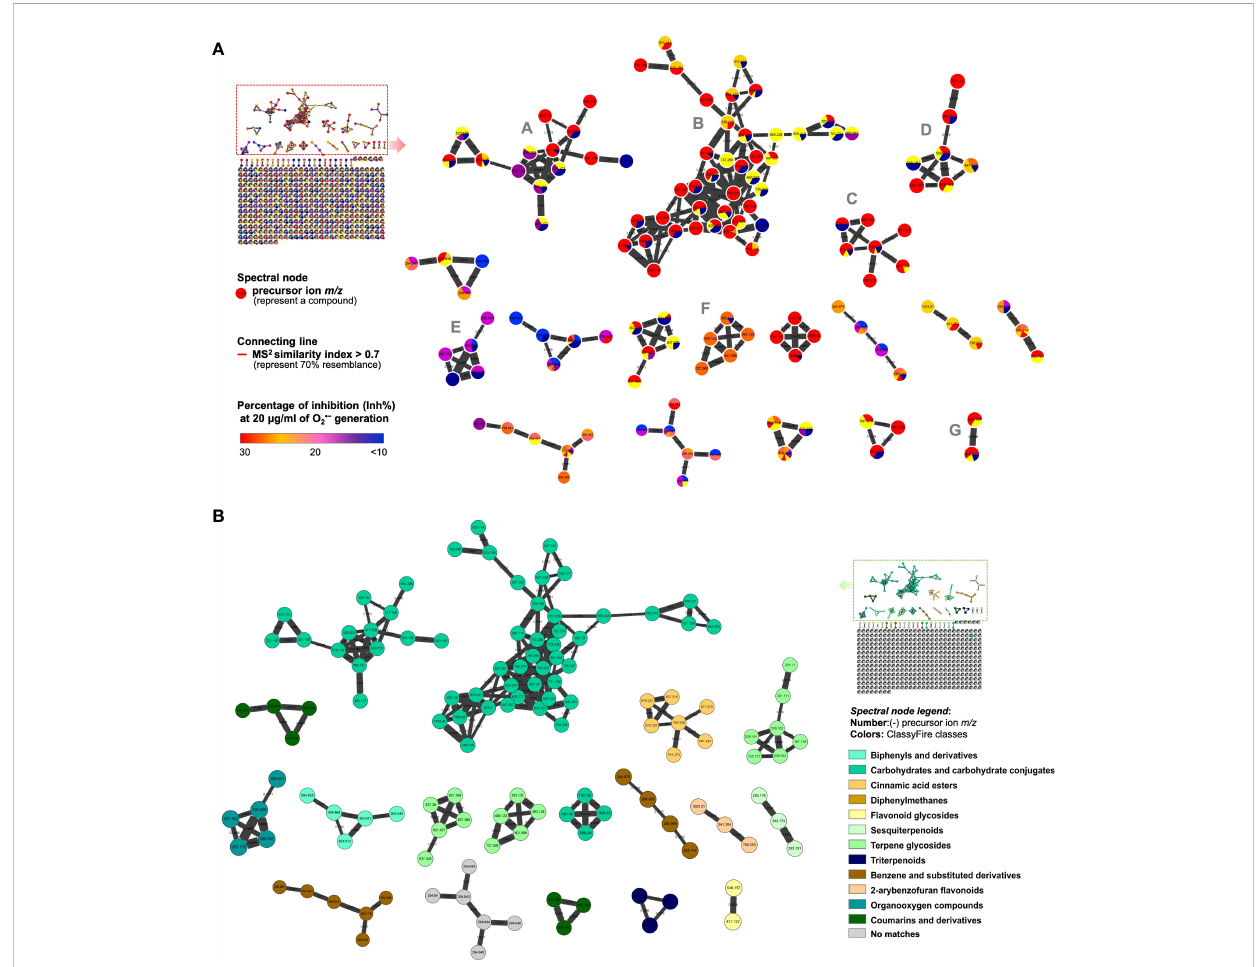
FIGURE 2 The MIMN illustrated the relationships between the metabolomic diversity and the anti-in fl ammatory properties of Scrophularia ningpoensis Hemsl. extract. (A) The established MIMN is based on the inhibition of O 2 (cid:129) − generation (20 m g/ml) in N -formyl methionyl-leucyl-phenylalanine (fMLF)-induced neutrophils and the spectral nodes were colored according to the levels of inhibition. The molecular clusters mentioned in the main text were marked with A-G. (B) The MIMN spectral nodes were labeled according to ClassyFire classes (categorized through their MS 2